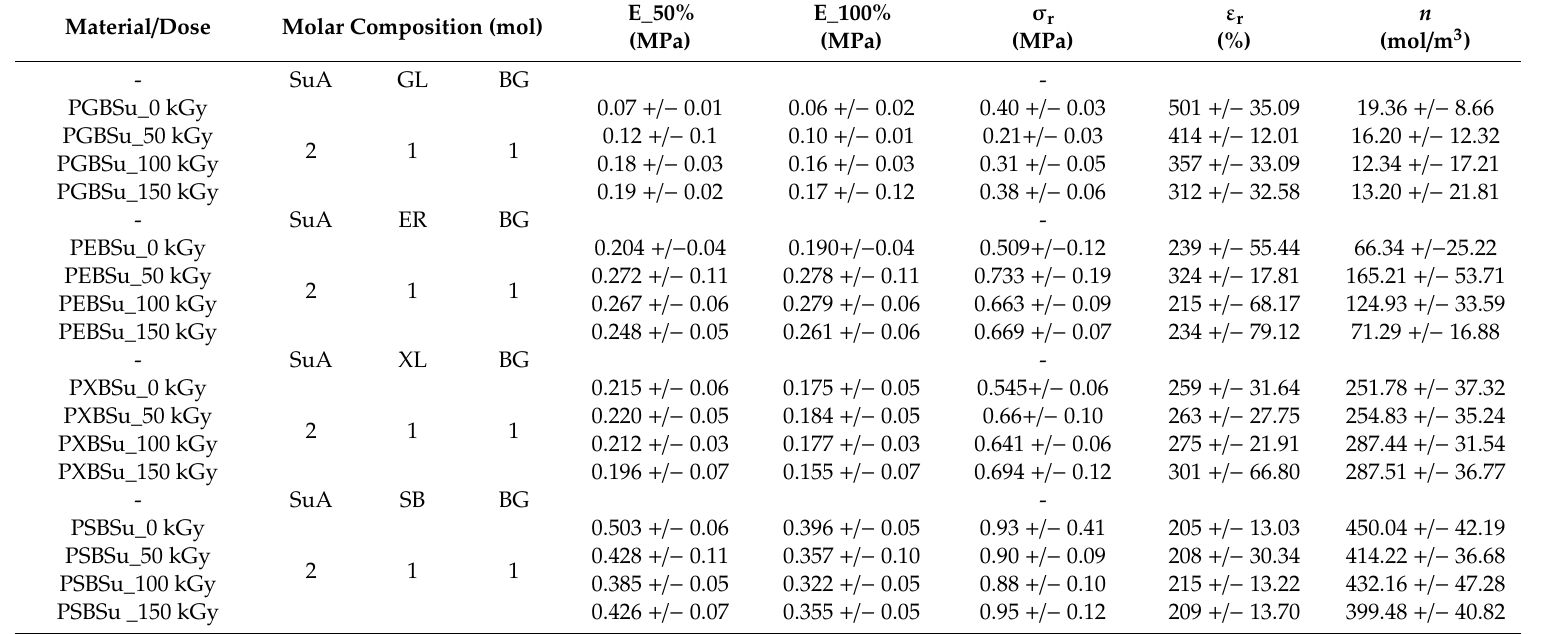
Table 2. Mechanical properties and cross-linking density of poly(glycerol succinate-co-butylene succinate) (PGBSu), poly(erythritol succinate-co-butylene succinate) (PEBSu), poly(xylitol succinate-co-butylene succinate) (PXBSu), poly(sorbitol succinate-co-butylene succinate). Data for both non-irradiated and radiation-modified materials is